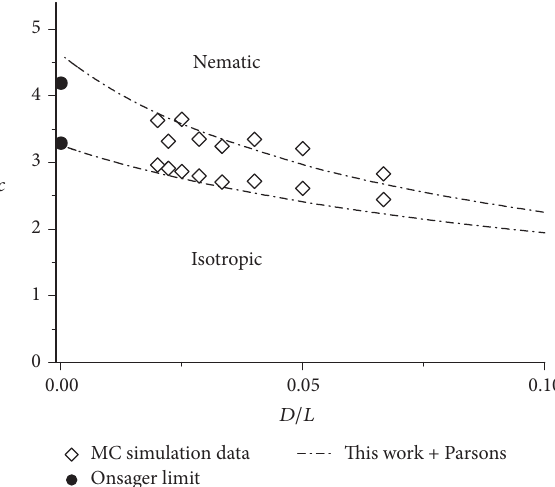
Figure 1: Aspect ratio dependence of the isotropic-nematic phase coexistence for hard spherocylinders. Dashed dotted curves are predictions using the proposed free energy correction inserted into Parsons-Lee theory. Monte Carlo (MC) computer simulation data were taken from Bolhuis and Frenkel